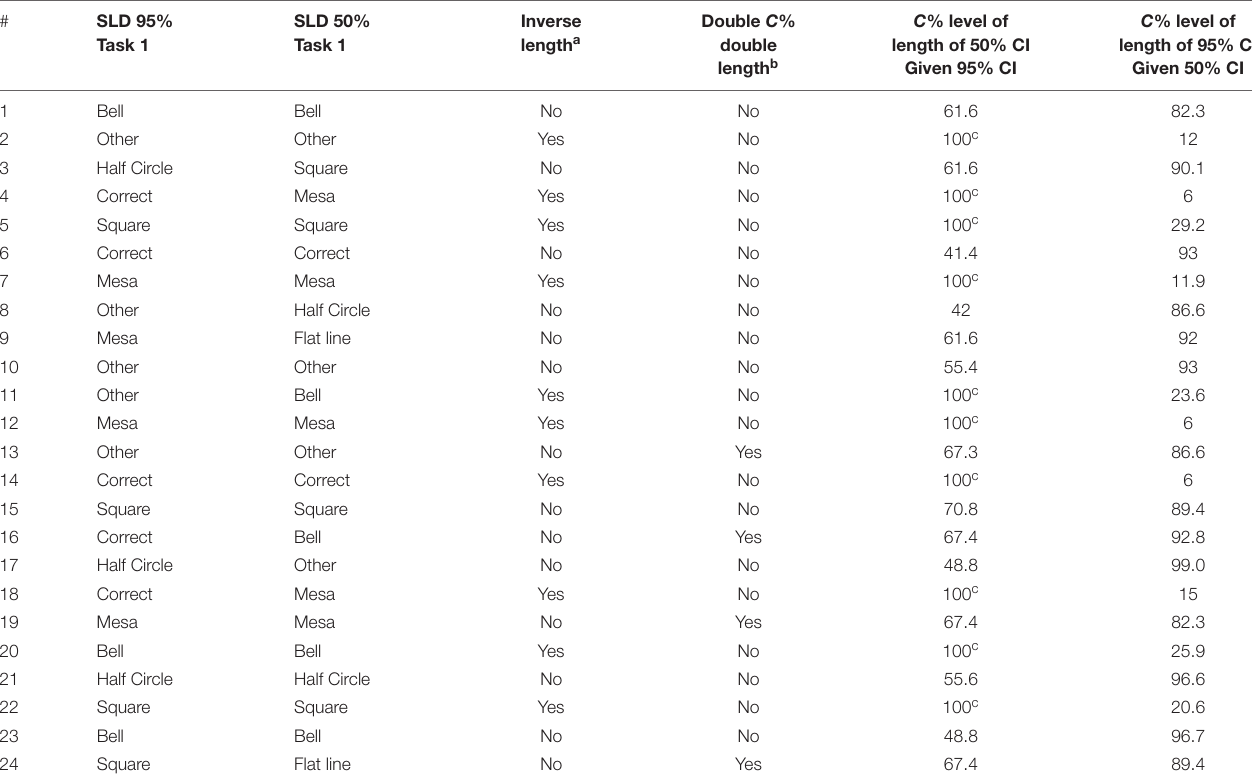
TABLE 3 | Summary of Study 2 participants’ results from Study 1 (Tasks 1 and